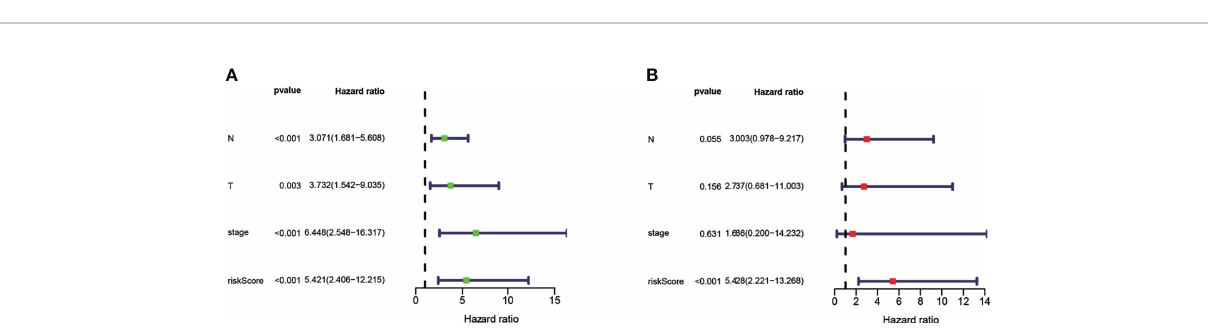
FIGURE 6 | Analysis of the risk scores as an independent prognostic indicator. (A) Univariate Cox regression analysis identi fi ed that N, T, stage, and risk score were signi fi cantly associated with OS prediction. (B) Multivariate Cox regression analysis identi fi ed that risk score was independent prognostic factor for